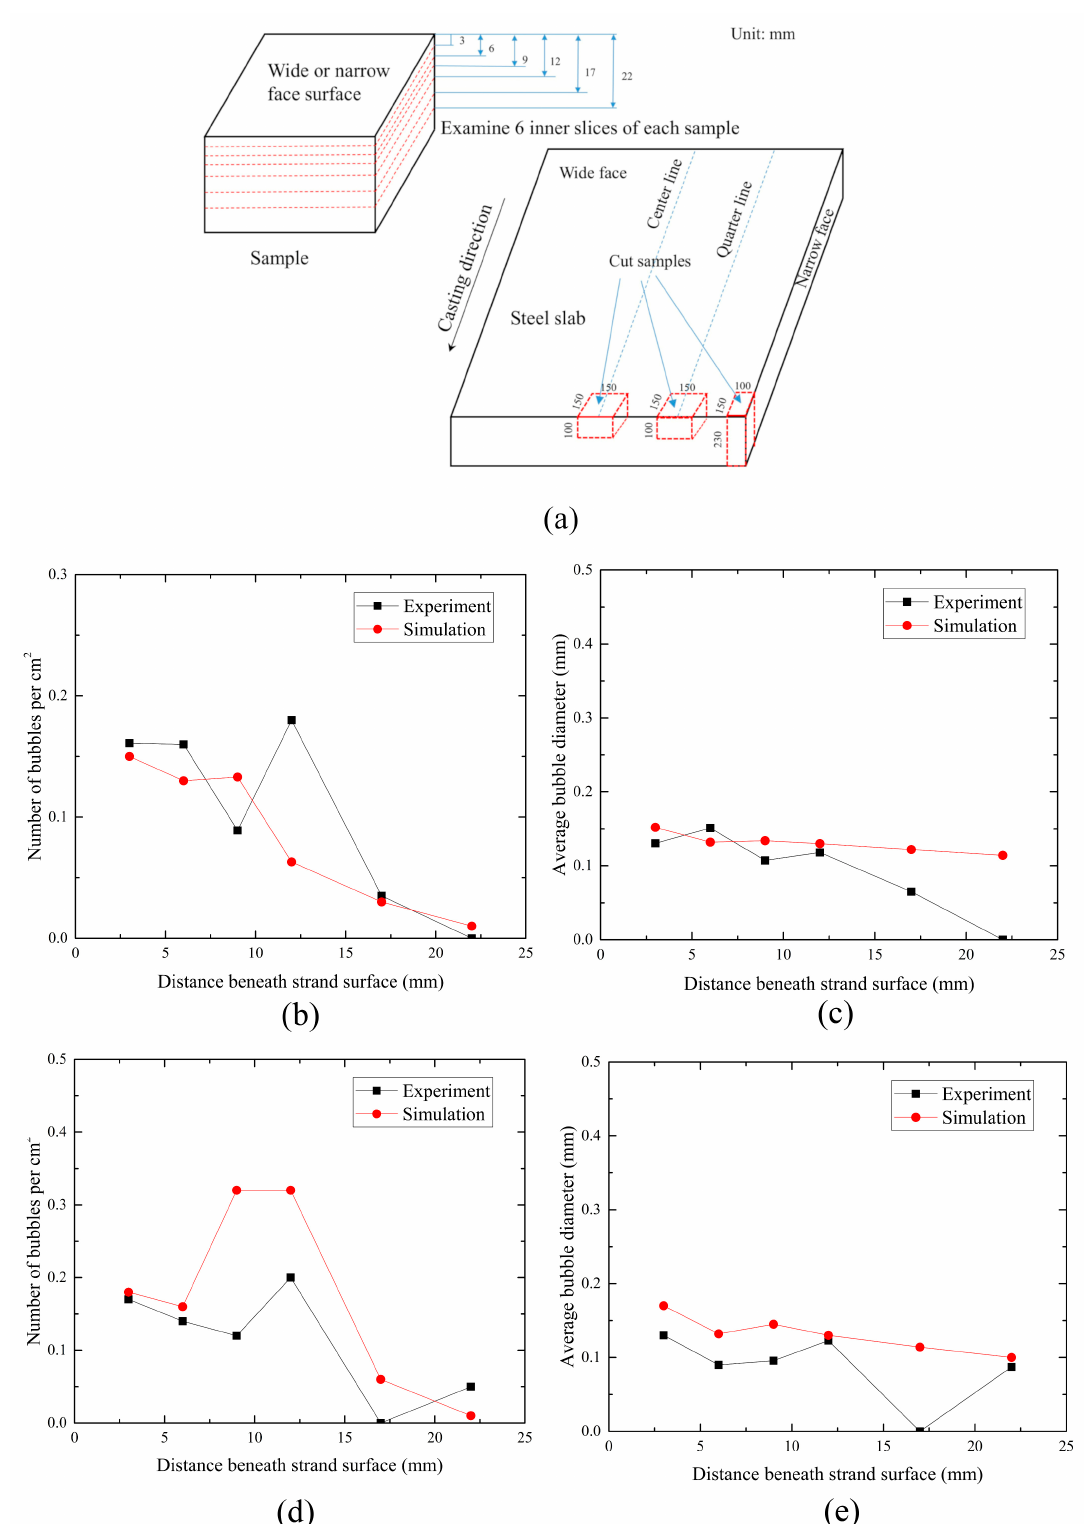
Figure 4. ( a ) Locations of samples and examined layers. Comparison between simulation and plant examination: ( b ) bubble number density on a wide face; ( c ) average bubble diameter on a wide face; ( d ) bubble number density on a narrow face and ( e ) average bubble diameter on a narrow face.